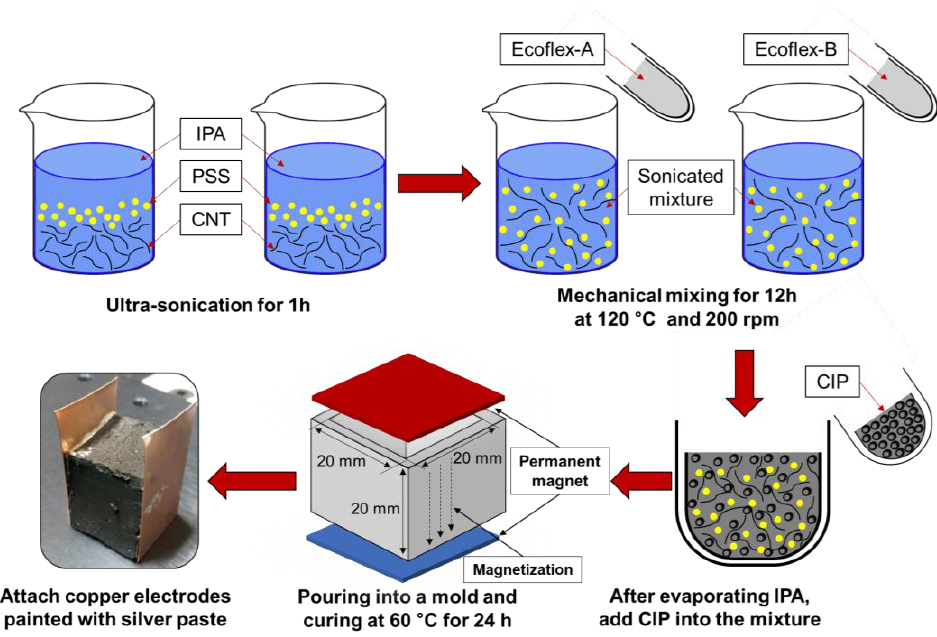
Figure 1. The fabrication process of the samples for magneto-sensor application.